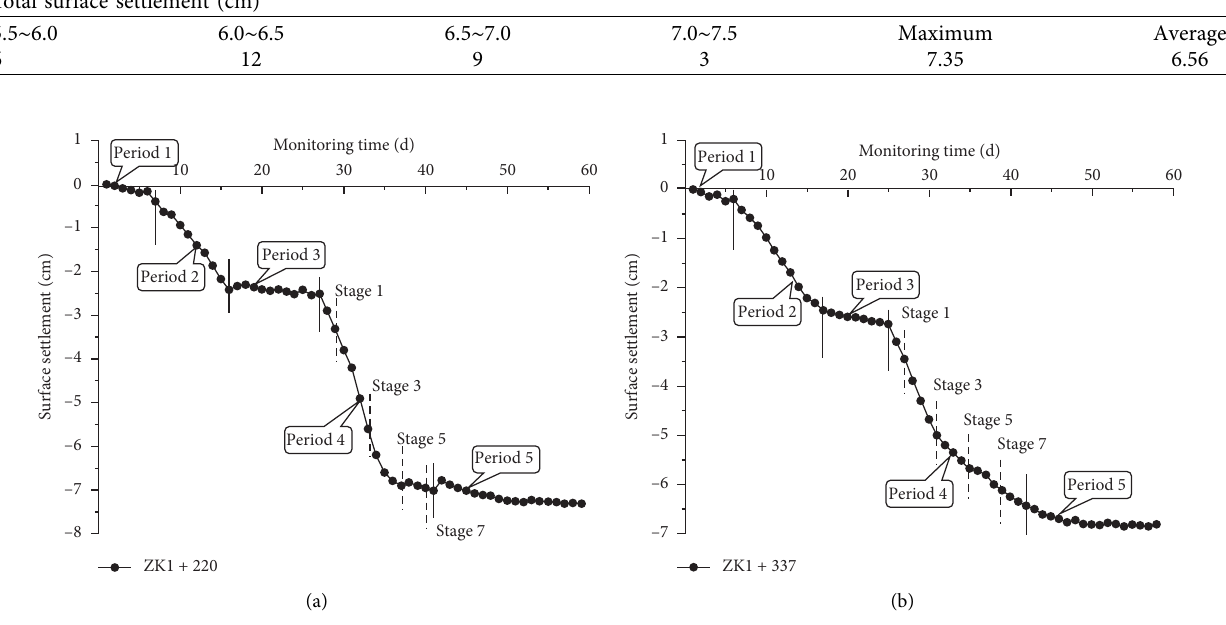
Figure 13: Measured time curves of surface settlement of section: (a) ZK1+220; (b) ZK1+337. Table 4: Statistics of total crown settlement (32 sections).